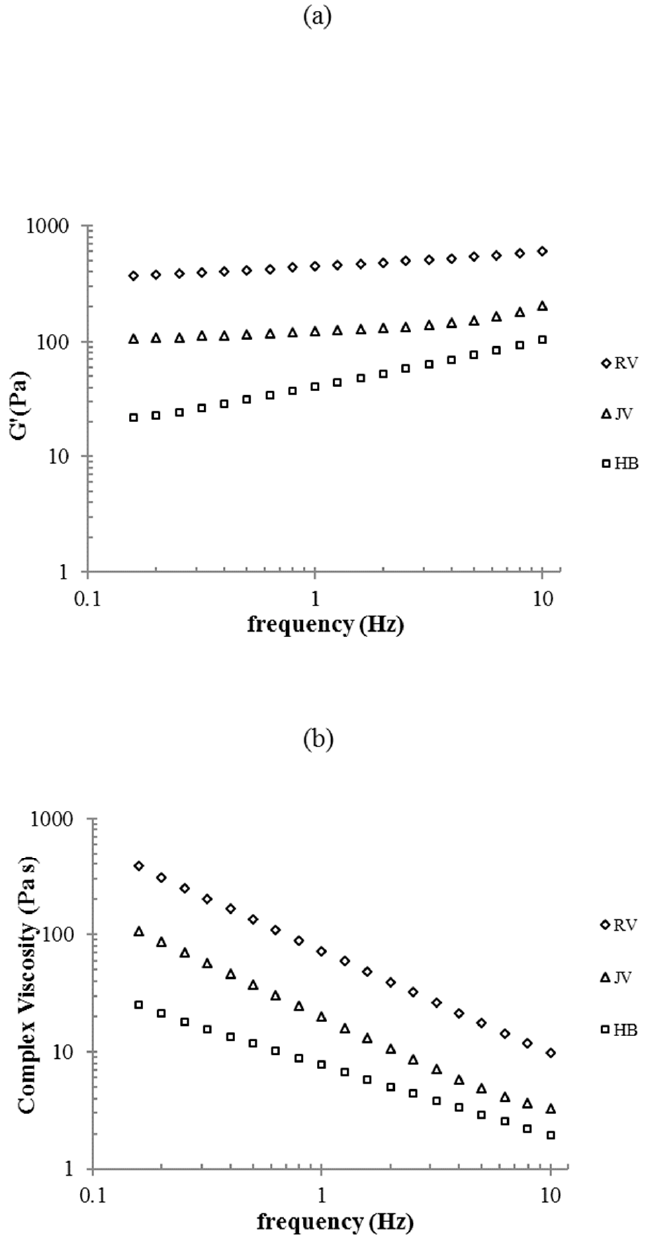
Figure 2. Rheological characterization. G’ values ( a ) and complex viscosity ( b ) as a function of the frequency. Measurements were performed at 37 ◦ C and 0.1% strain.